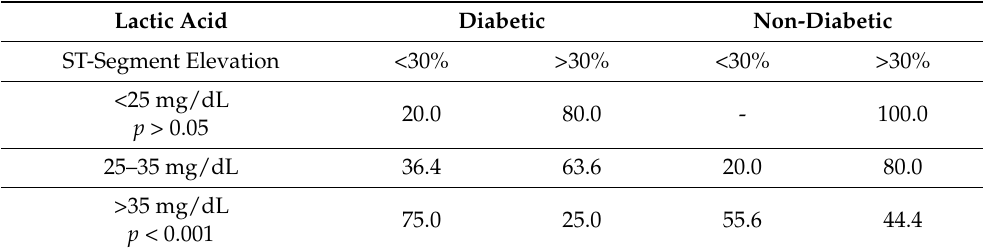
Table 6. Correlation of lactic acid values with ST-segment elevation.